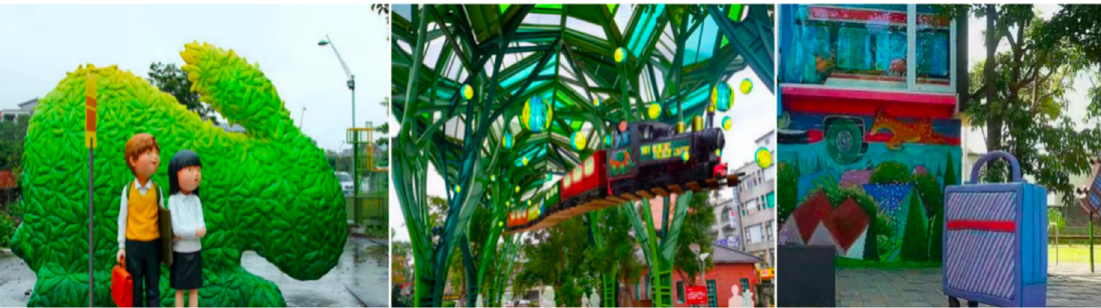
Figure 7. 3D art at Yilan Railway Station, Yilan, Taiwan. Reprinted with permission from first author. Copyright 2018, Luo Na.